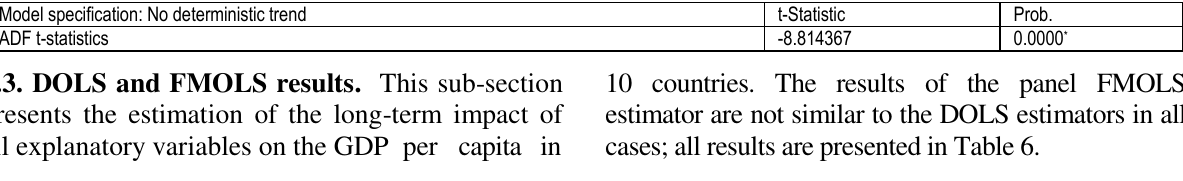
Table 5. Kao residual cointegration test result